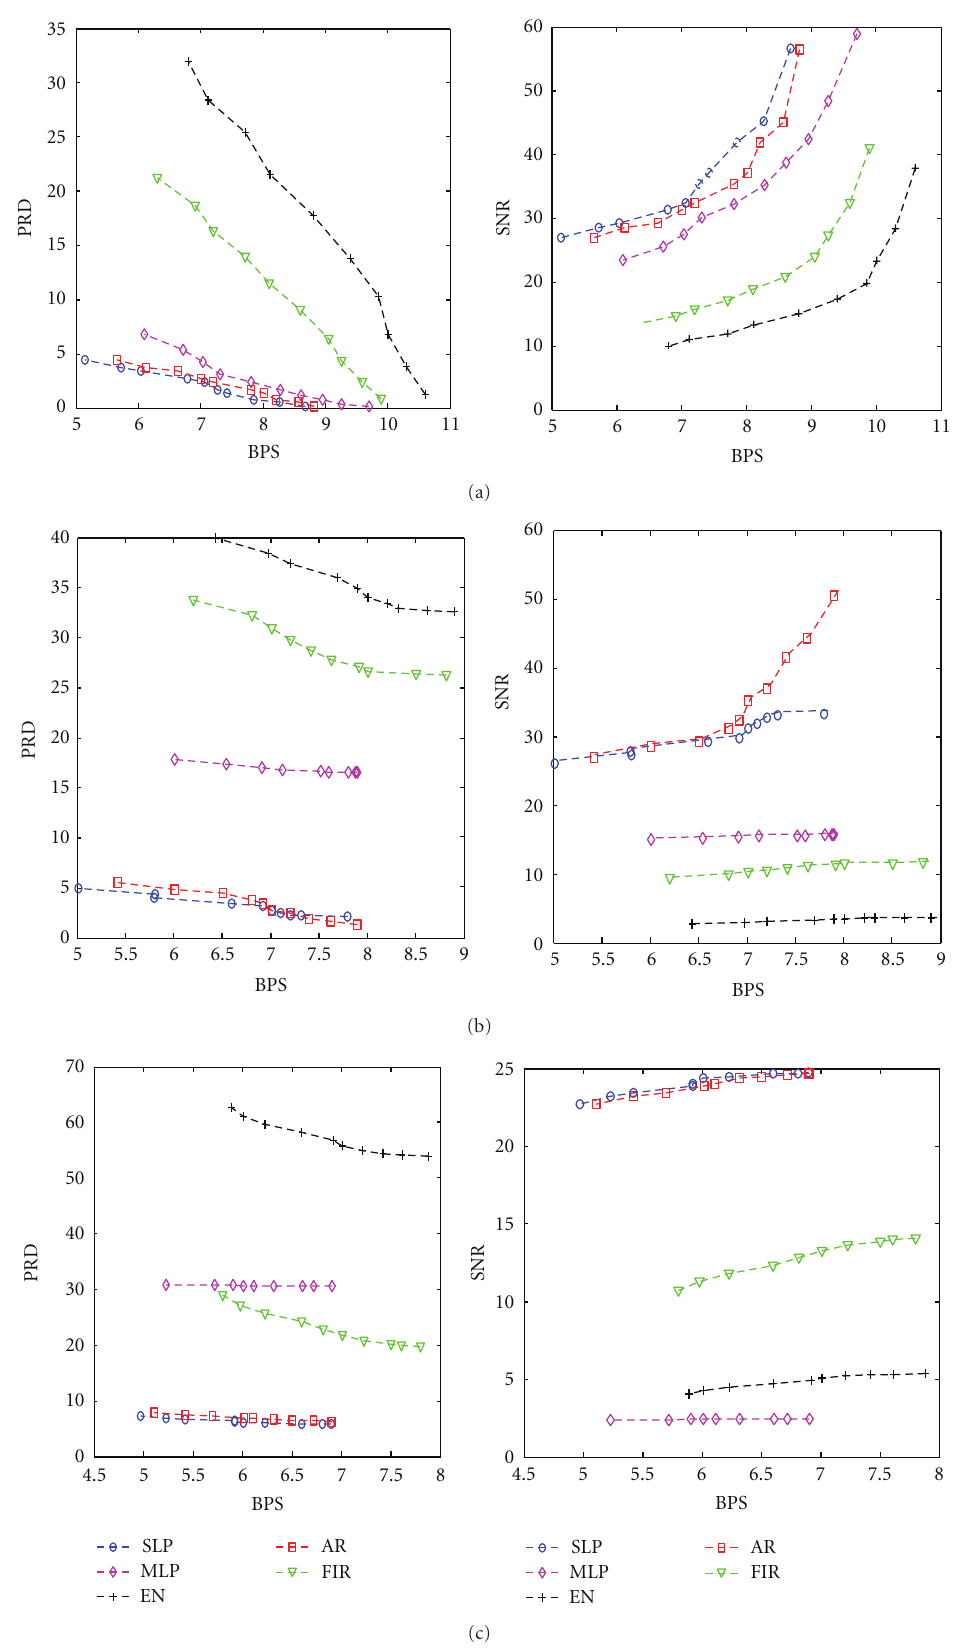
Figure 6: BPS versus PRD and BPS versus SNR characteristics at di ff erent quantization levels, (a) Q1, (b) Q2, and (c)